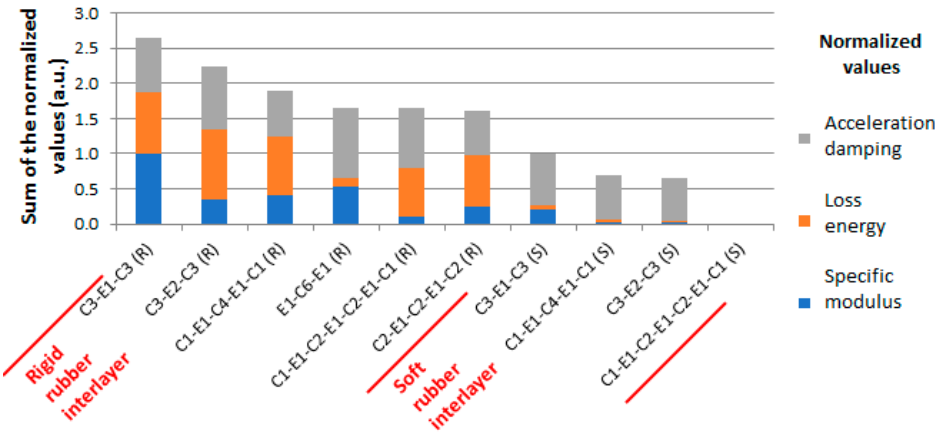
Figure 7. Normalized static and dynamic performances of all the hybrid composites.